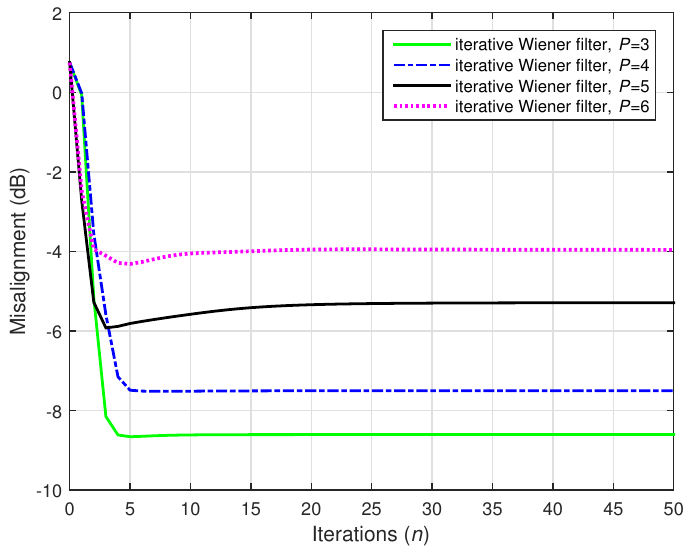
Figure 14. Performance of the iterative Wiener filter with different values of P , using N = 2000. The input signals were independent AR(1) processes, M = 4, L = 500, and SNR = 10